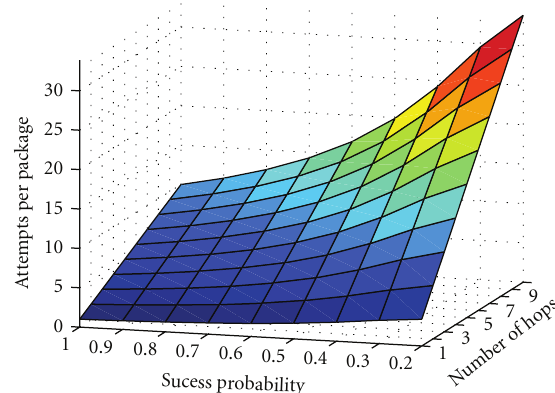
Figure 10: Number of transmissions required for a packet to cross a WSN, with variable length and success